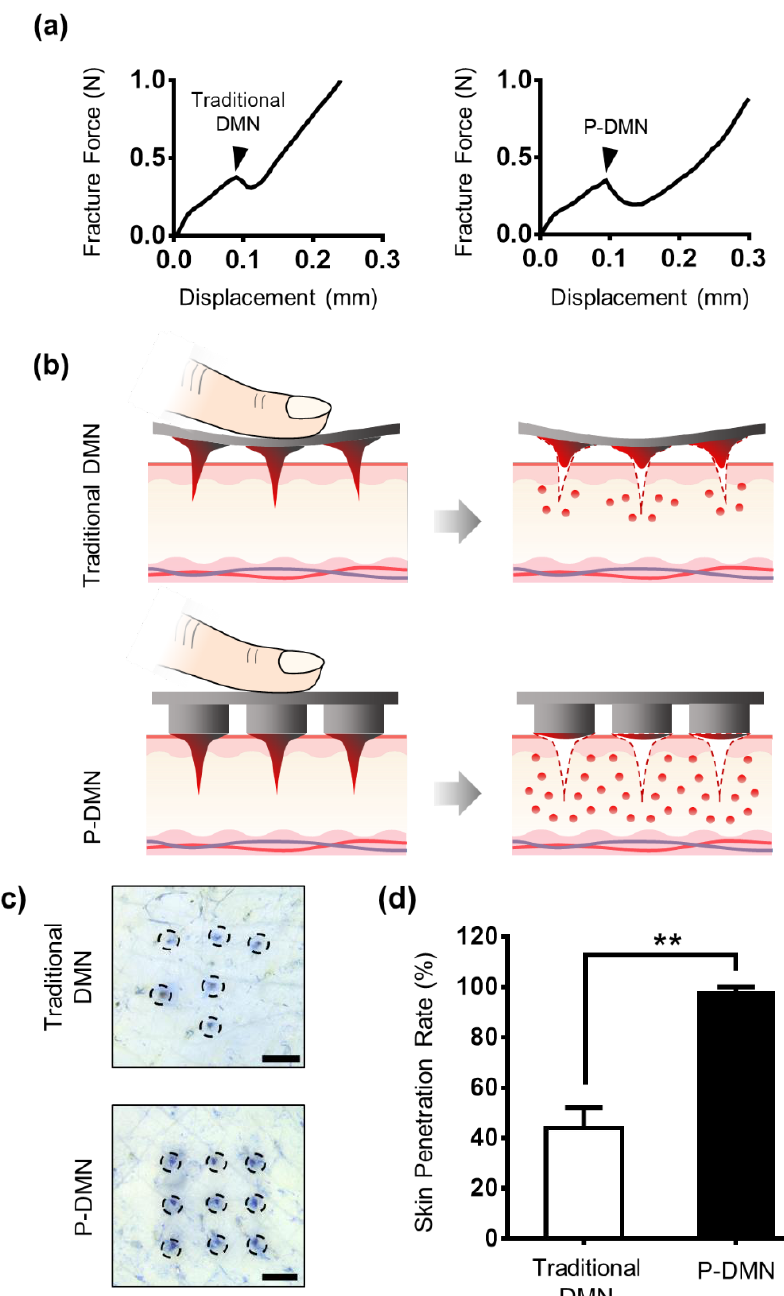
Figure 2. Assessment of mechanical force and penetration of micro-pillar integrated dissolving microneedles (P-DMNs). ( a ) The mechanical fracture force of DMNs confirmed their ability to penetrate the skin without breakage. Arrows indicate the breakage points. ( b ) Illustration of DMN application onto the skin. We hypothesized that unlike in traditional DMNs, the uniform distribution of the application force in P-DMNs would result in an accurate and complete delivery of the encapsulated drugs. ( c ) Skin penetration comparison of DMNs. Traditional DMNs showed an incomplete array of spots, whereas a uniform pattern of 3 × 3 spots was achieved in P-DMN-treated skin. ( d ) Evaluation of skin penetration success rate. Scale bars in ( c ) are 1 mm. ** p < 0.01.